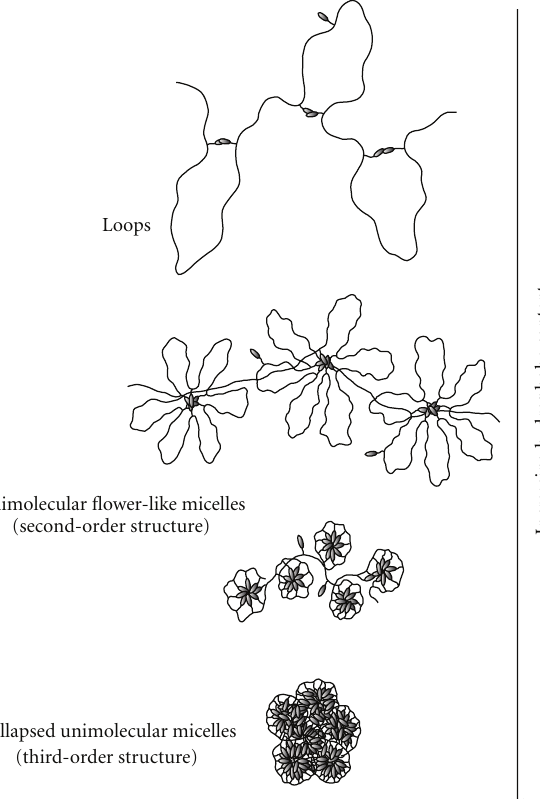
Figure 3: Intrapolymer hydrophobe